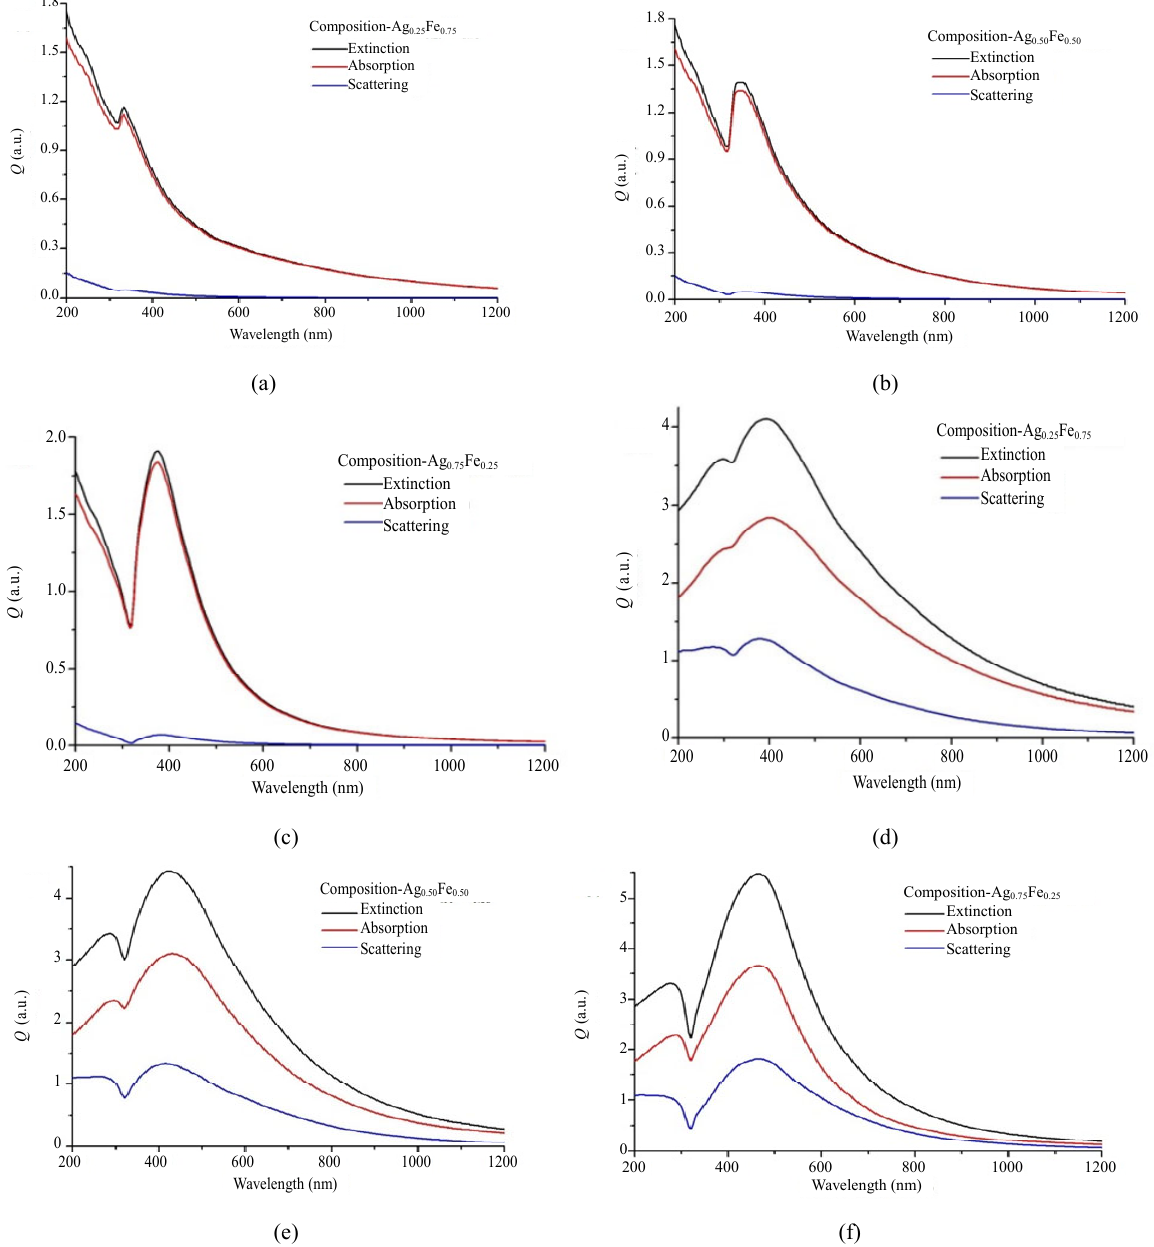
Fig. 3 Extinction, absorption, and scattering spectra for Ag-Fe bimetallic nanoparticles of different alloy compositions with particle size of 20 nm in (a), (b), and (c) and particle size of 70 nm in (d), (e), and